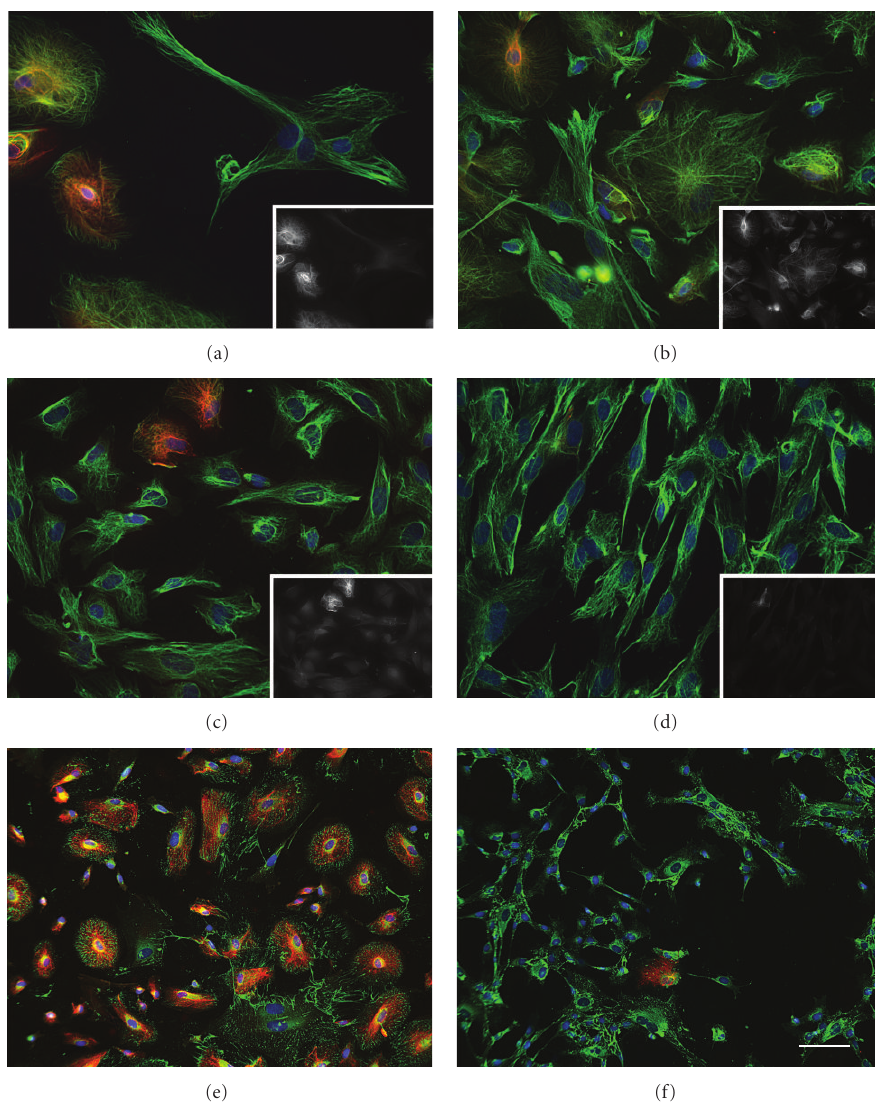
Figure 7: Immunostaining of keratin, vimentin, and fibronectin in mixed cell populations. Mixed cell populations (a, e) ChM1, (b) ChM2, (c, f) ChM3, and (d) ChM4 were immunostained with antibodies against (a–f) keratins (red), (a–d) vimentin or (e, f) fibronectin (green) and (a–f) a fluorescent chromatin dye (blue). Insets in (a–d) show images of keratin signal at low magnification (0.3x). Scale bar, (a–d) 50 microns, (e, f) 100